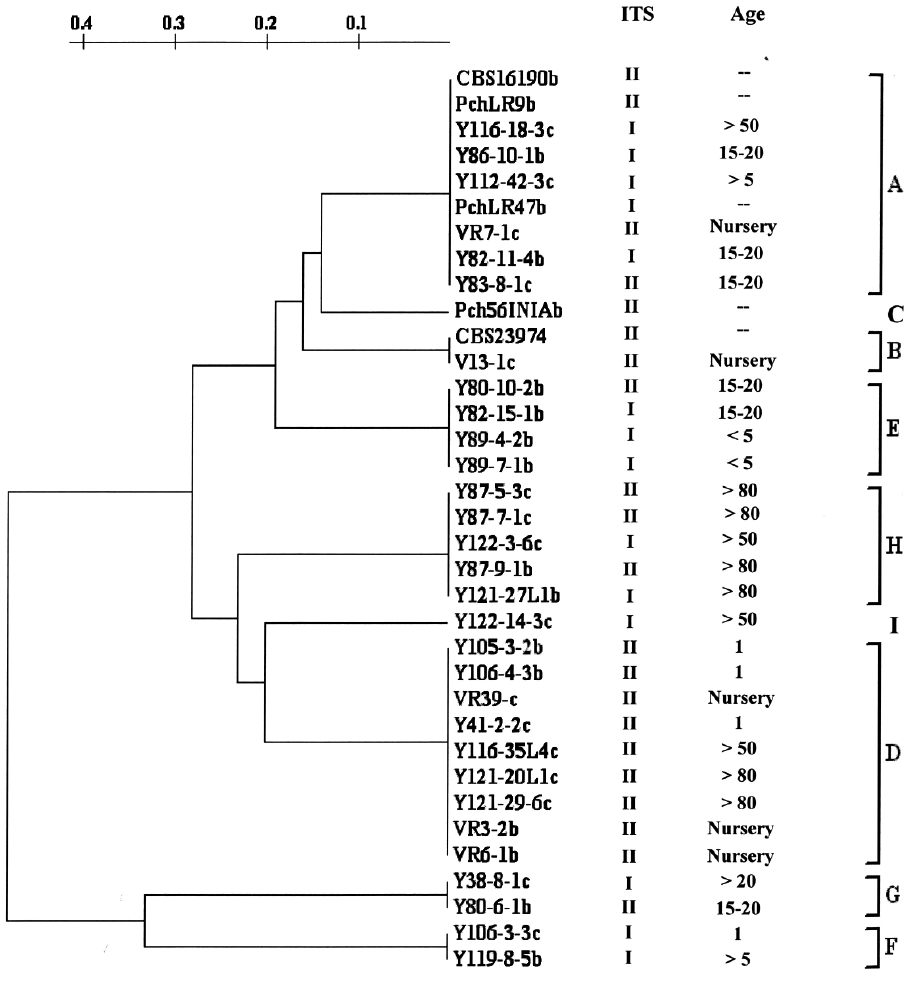
Fig. 2. Dendrogram depicting RAPD patterns of genetic variation among 35 isolates of Phaeomoniella chlamydospora . Sequence variations found in the ITS4-ITS5 fragments divided the isolates into two groups: 14 isolates had A369 and C438 (group I), and 21 had T365 and T438 (group